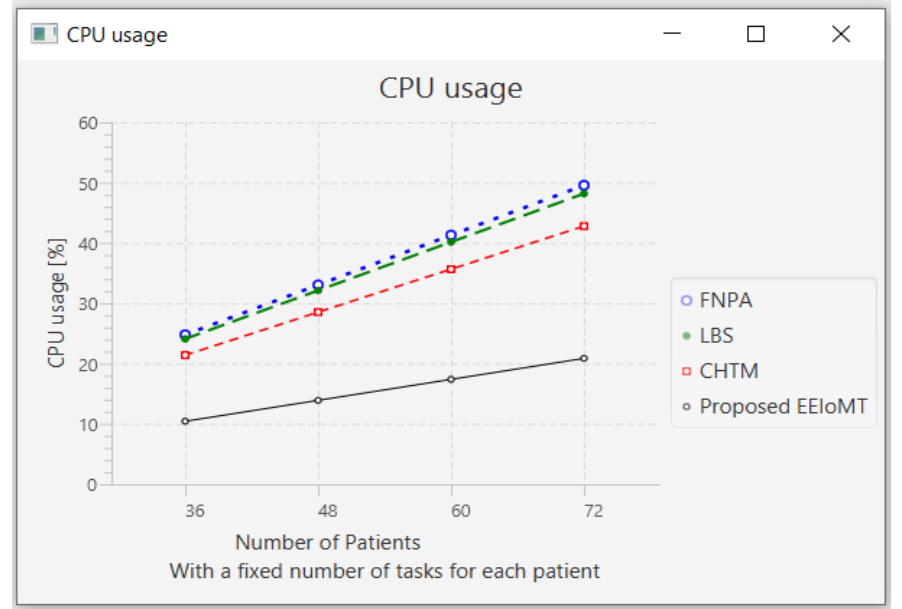
Figure 10. Network usage comparison when changing the number of patients.